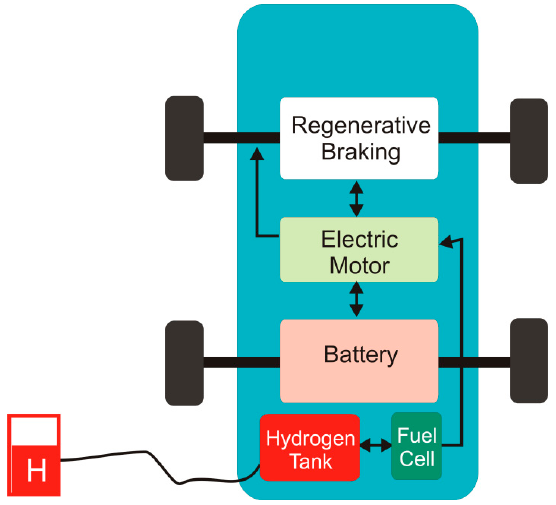
Figure 4. Architectural diagram of fuel-cell electric vehicles (FCEVs).